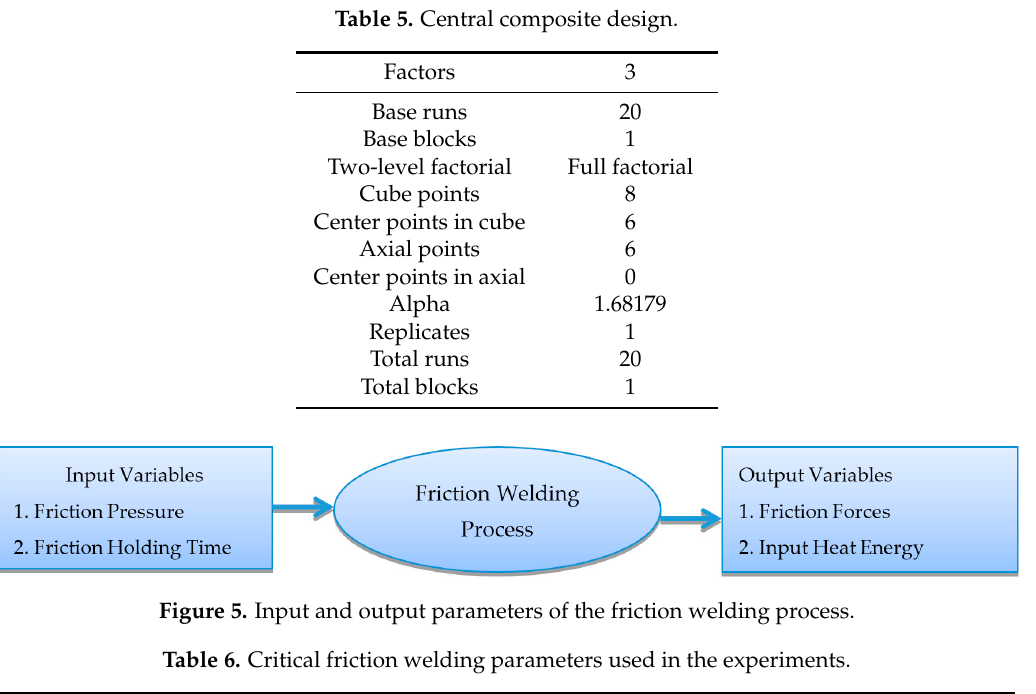
Table 5. Central composite design.